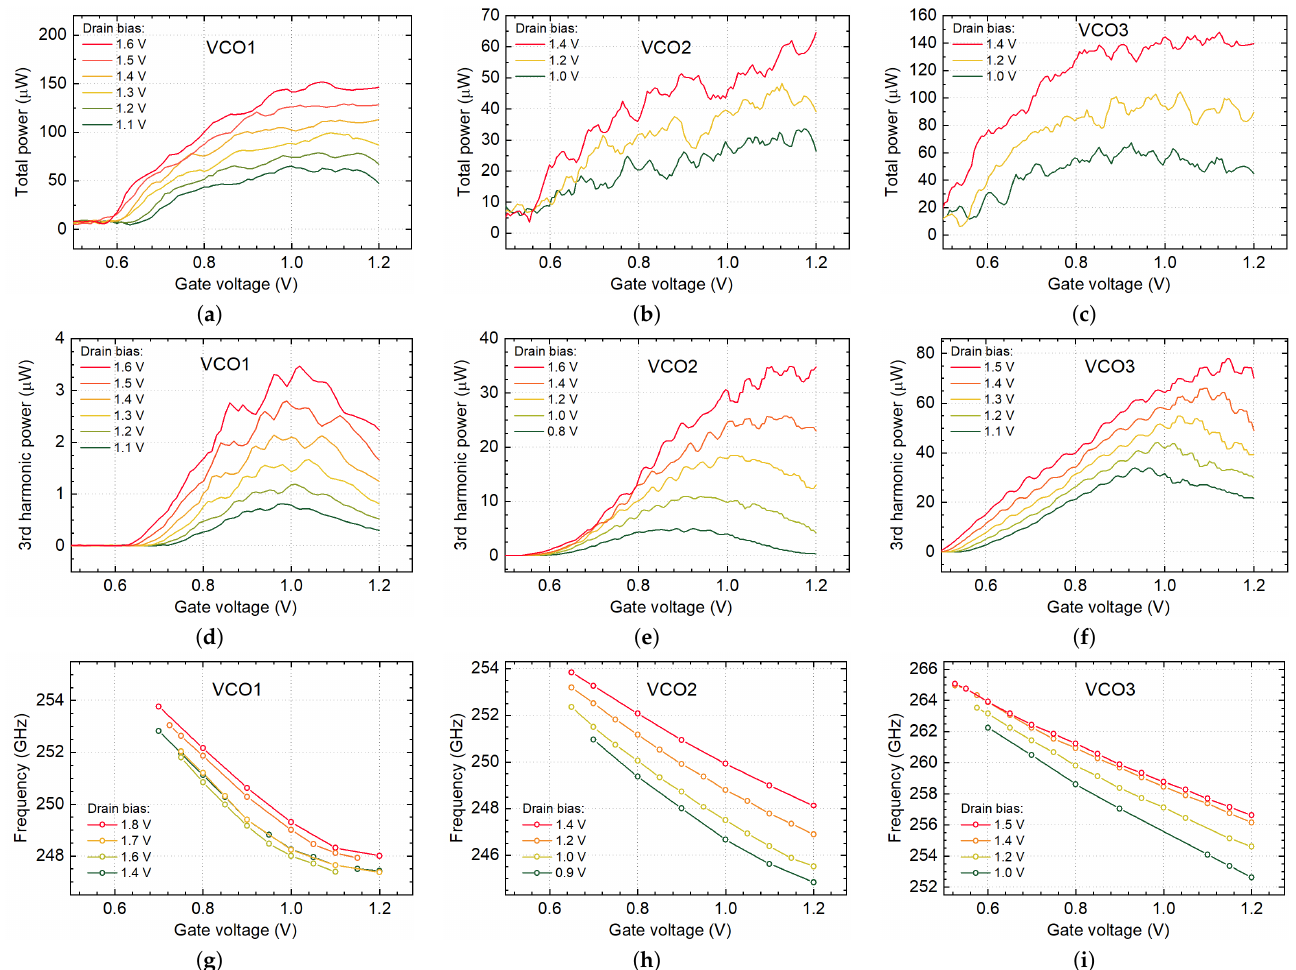
Figure 11. The proposed VCOs’ measured total power ( a – c ), 3rd harmonic power ( d – f ), and frequency ( g – i ) dependency on the gate V g and drain V d